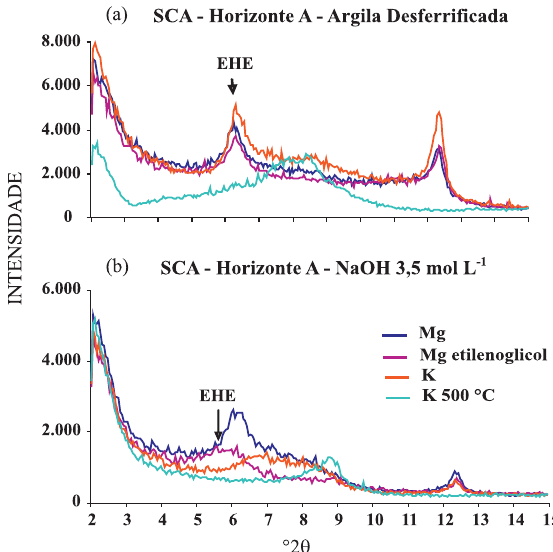
Figura 5. Difratogramas de raios X de amostras orientadas de argila do horizonte A do Setor de Ciências Agrárias (SCA) da UFPR, submetidas a tratamentos auxiliares: a) desferrificada; b) desferrificada e tratada com solução de NaOH 3,5 mol L -1 . EHE - esmectita com hidroxi-Al entrecamadas. Espaçamento basal d(001): (a) Mg - 1,42 nm, Mg etilenoglicol - 1,42 nm, K - 1,42 nm; K 550 °C - 1,09 nm; (b) Mg - 1,4 nm; Mg etilenoglicol - 1,60 nm; K - 1,26 nm; K 550 °C - 1,00 nm.